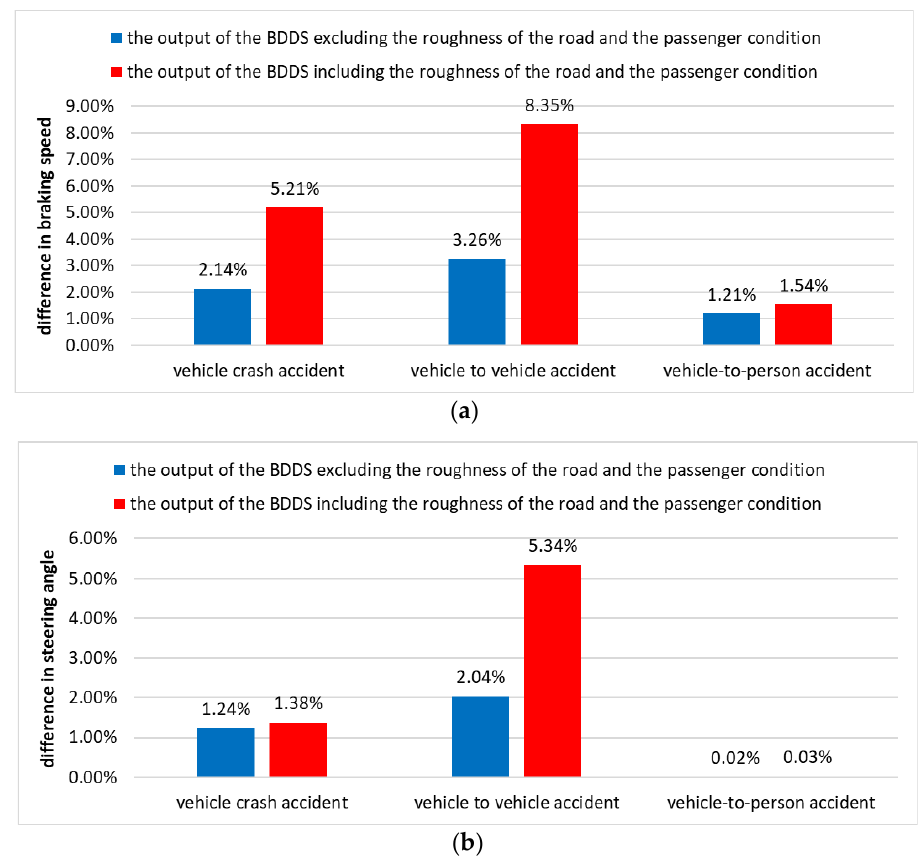
Figure 11. ( a ) Difference between accident data and BDDS results (braking speed). ( b ) Difference between accident data and BDDS results (steering angle).